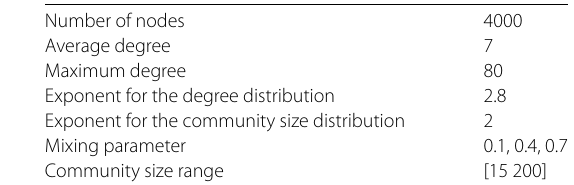
Table 2 LFR network